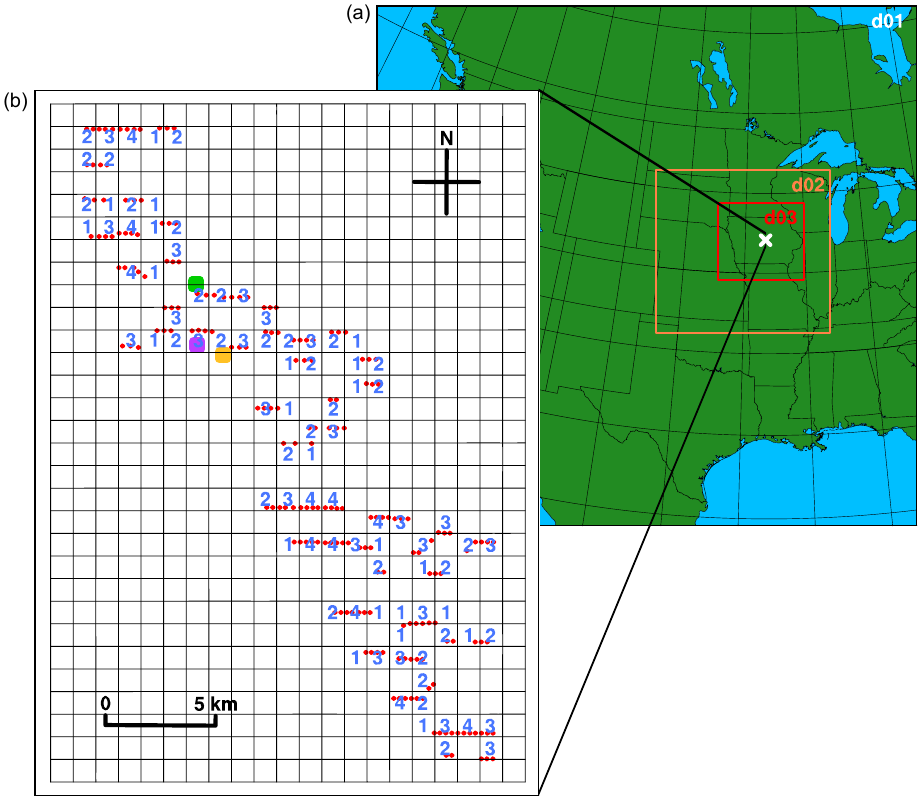
Figure 1. Map of the three domains (d01, d02, and d03) in the WRF simulations (a) , with the white “x” representing the CWEX-13 wind farm. Zoom-in map of the wind farm (b) , with the black horizontal and vertical lines outlining the WRF grid cells, the red dots as the actual locations of wind turbines, the blue numbers as the number of wind turbines per WRF grid cell, the yellow square as the WC lidar, the green square as the 200S lidar, and the purple square as the surface flux station. Other instruments were deployed in CWEX-13, and only the instruments used herein are